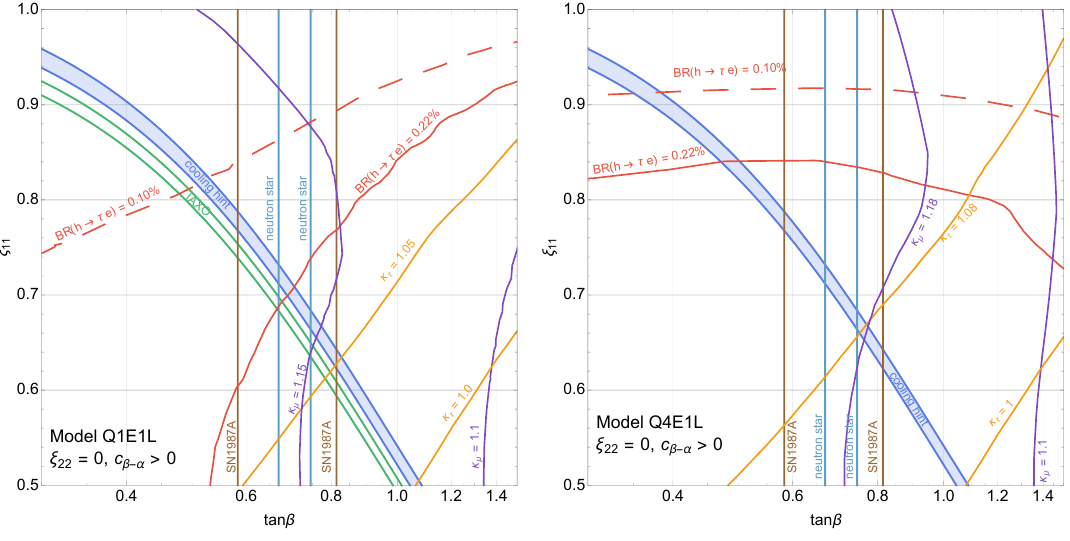
Figure 5 . The same as in figure 4 but for f a = 10 8